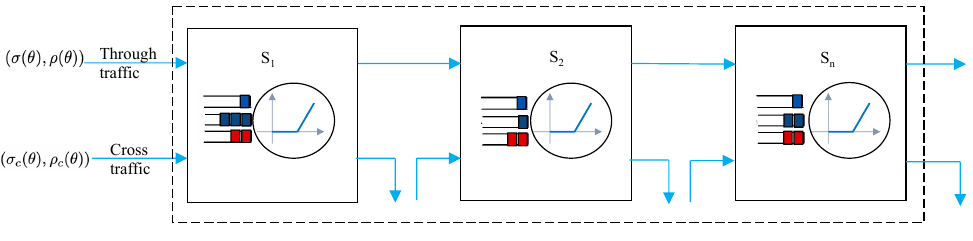
Figure 3. Tandem servers with cross